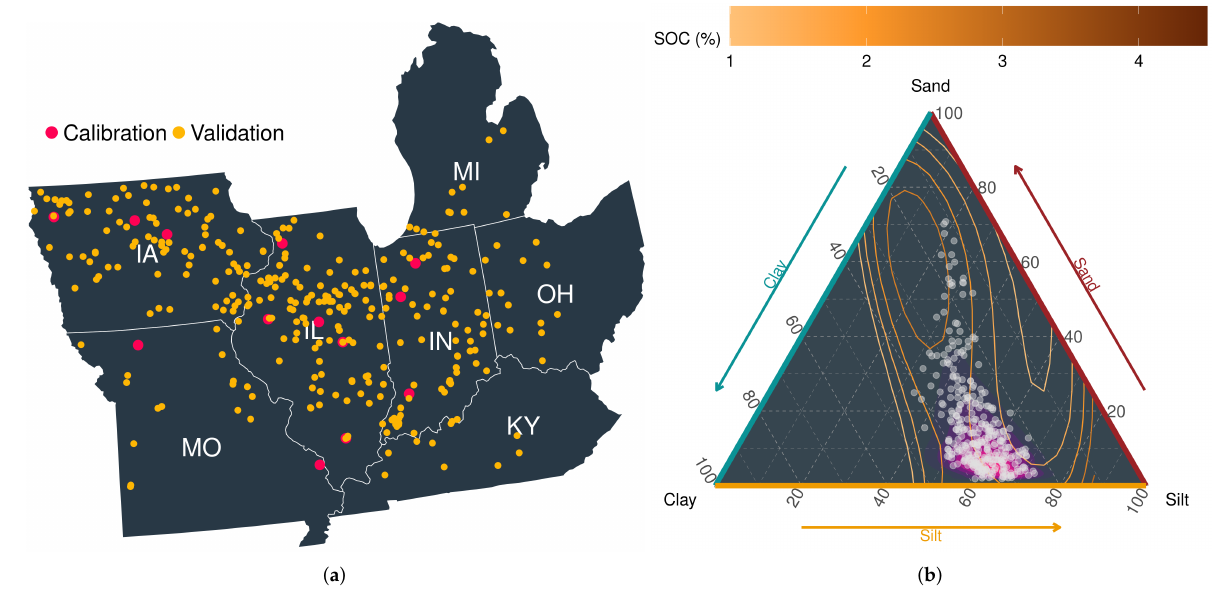
Figure 2. ( a ) Geographical location and ( b ) distribution of basic soil properties of calibration and validation sites. SOC: Soil Organic